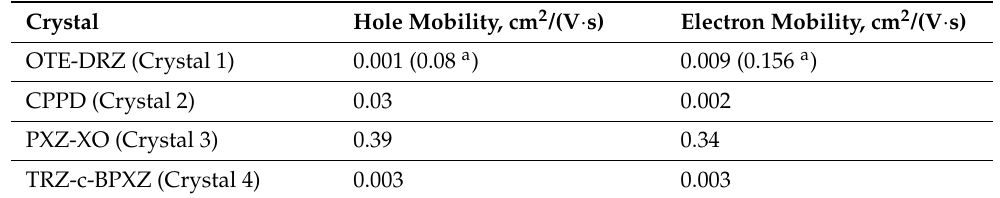
Table 3. Charge carrier mobilities in the crystals studied. Crystal Hole Mobility, cm 2 /(V ·